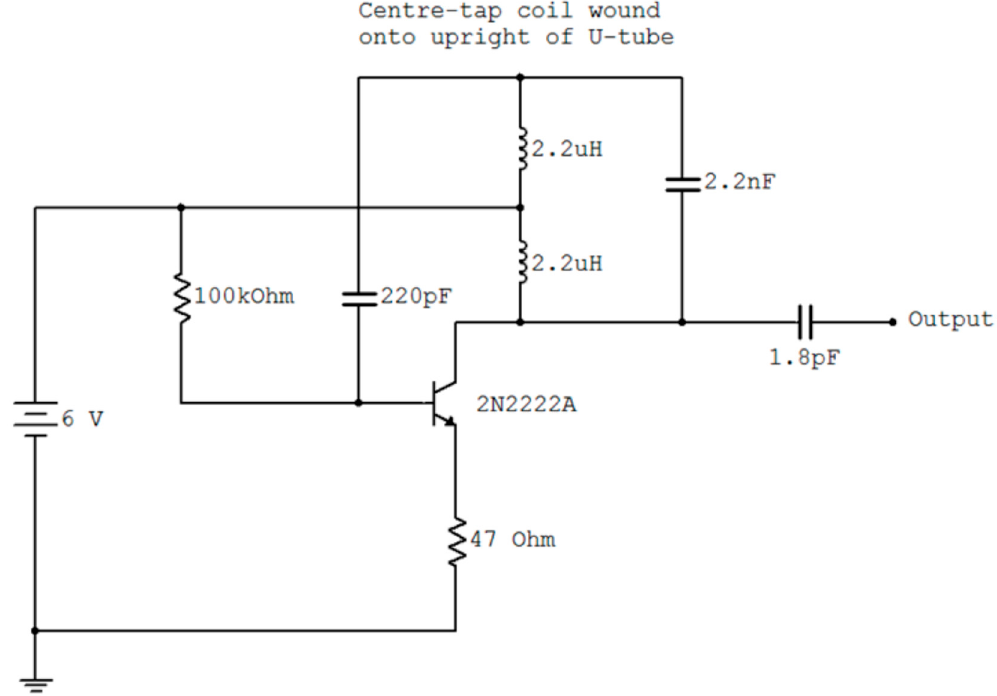
Figure 7. Hartley radio frequency (RF) oscillator circuit diagram.